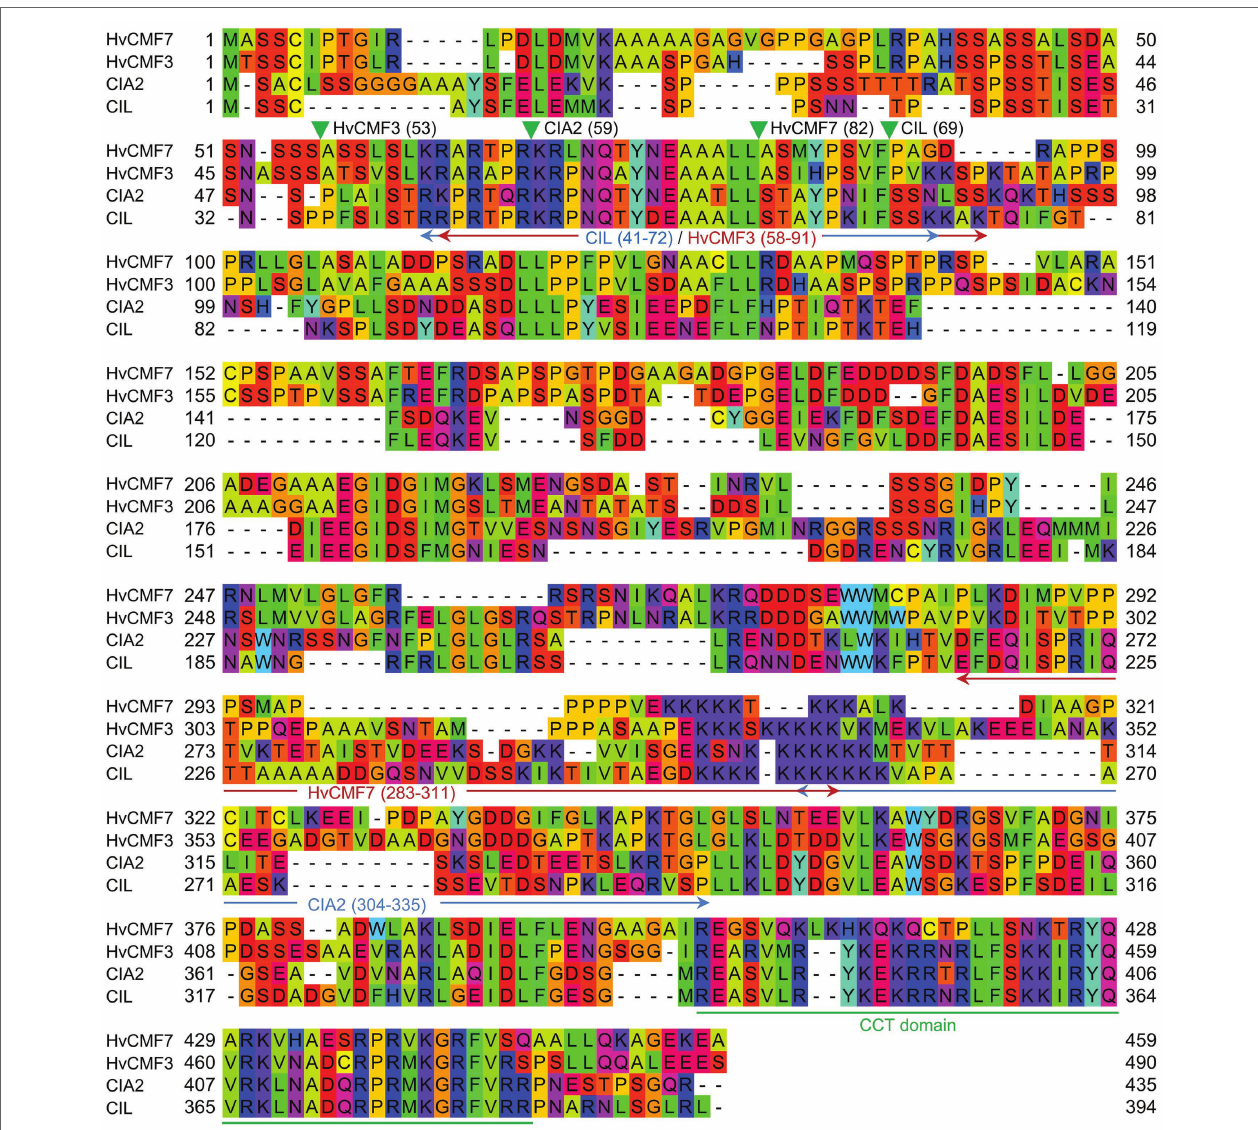
FIGURE 1 | Alignment of protein sequences of HvCMF7, HvCMF3, Chloroplast Import Apparatus 2 (CIA2), and CIA2-like (CIL). Green filled triangles show cleavage sites of chloroplast transit peptide (cTP) predicted by ChloroP (Emanuelsson et al., 1999) and arrows indicate nuclear localization signal (NLS; cutoff score ≥ 4.0) predicted by cNLS Mapper (Kosugi et al., 2009). Numbers in parentheses indicate amino acid positions in the respective proteins. The CCT domain is underlined in